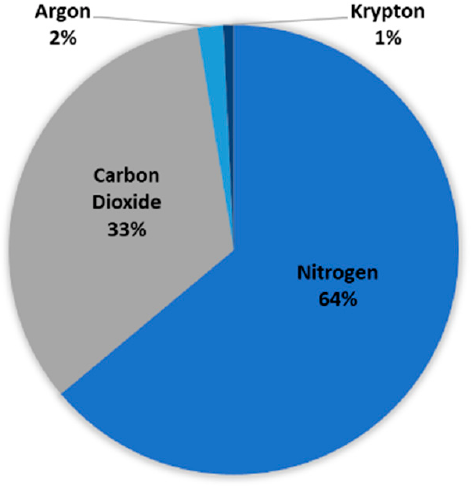
Figure 5. Representation of the use of different gases for pore structure analysis in the selected literature. (Elaborated from analysis of articles in the attached Excel file).